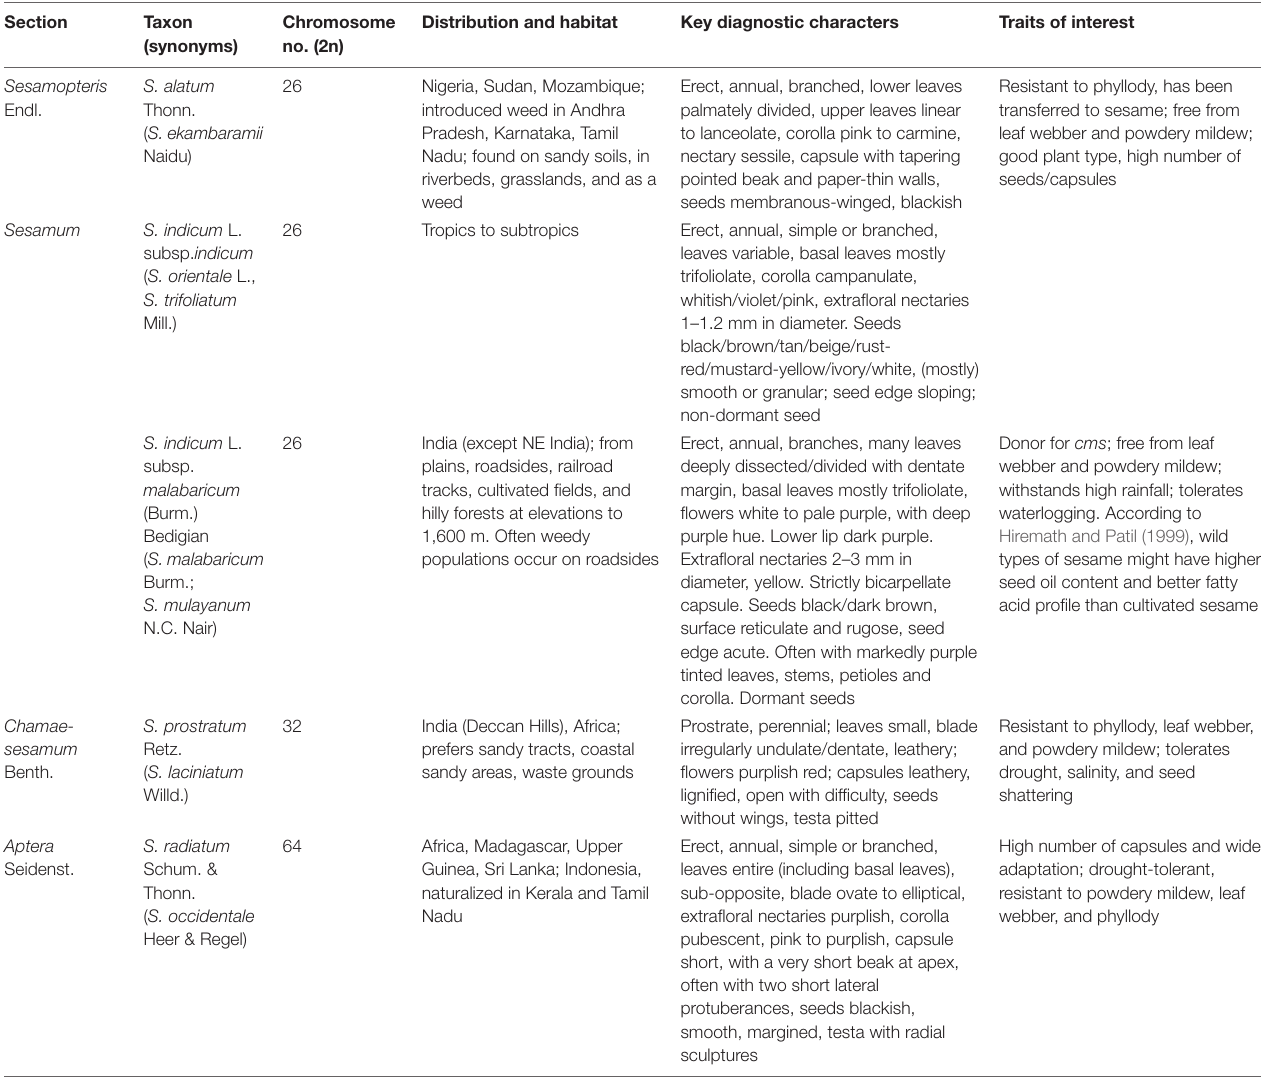
TABLE 1 | Different sesame species endowed with specific key traits.